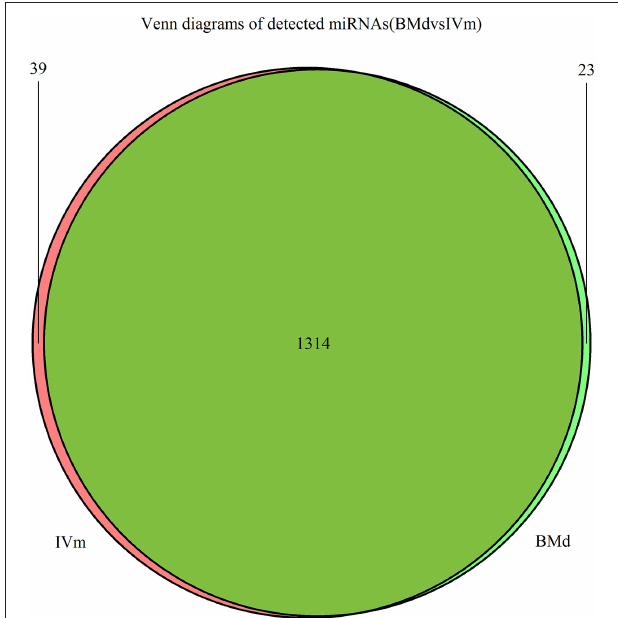
FIGURE 2 | Venn diagram of the miRNAs in the apple twig bark in response to V. mali and the mock control. Venn diagram showing the miRNA candidates that are commonly expressed in the apple twig bark in response to V. mali (IVm) and the mock control (BMd) samples, as well as those expressed exclusively under one treatment but not the other.